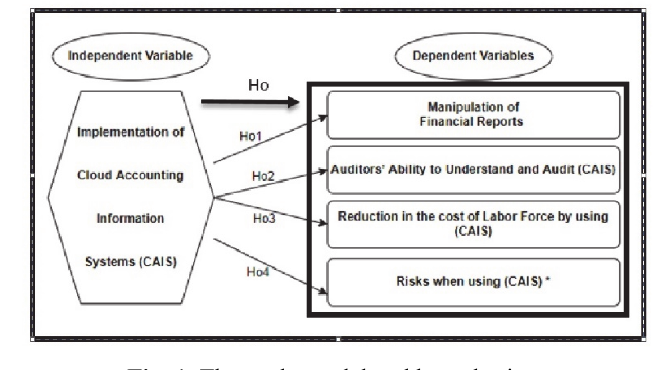
Fig. 1. The study model and